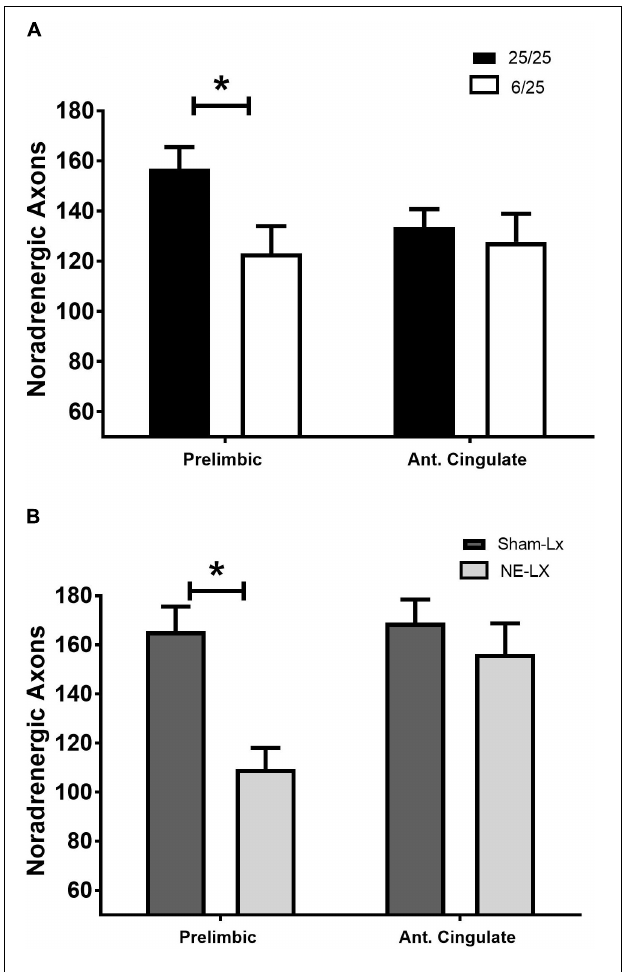
FIGURE 2 | (A) Rats exposed to prenatal malnutrition (6/25; white bars) had significantly fewer noradrenergic axons in PL than well-nourished control subjects (25/25; black bars). There was no difference between the number of noradrenergic axons in the ACC between control and malnourished rats. (B) Data from experiment two is shown with control subjects indicated by dark gray bars (SHAM-LX) and lesioned rats indicated by light gray bars (NE-LX). Infusions of DBH-saporin produces noradrenergic deafferentation in the PL cortex while sparing fibers in the nearby ACC. Though the extent of noradrenergic damage produced by lesioning the PL was greater than the extent of damage found to result from malnutrition (38% reduction in axons due to lesioning vs. 21.7% after malnutritions), damage following both treatments was limited to the PL. ∗ indicates p < 0.05.